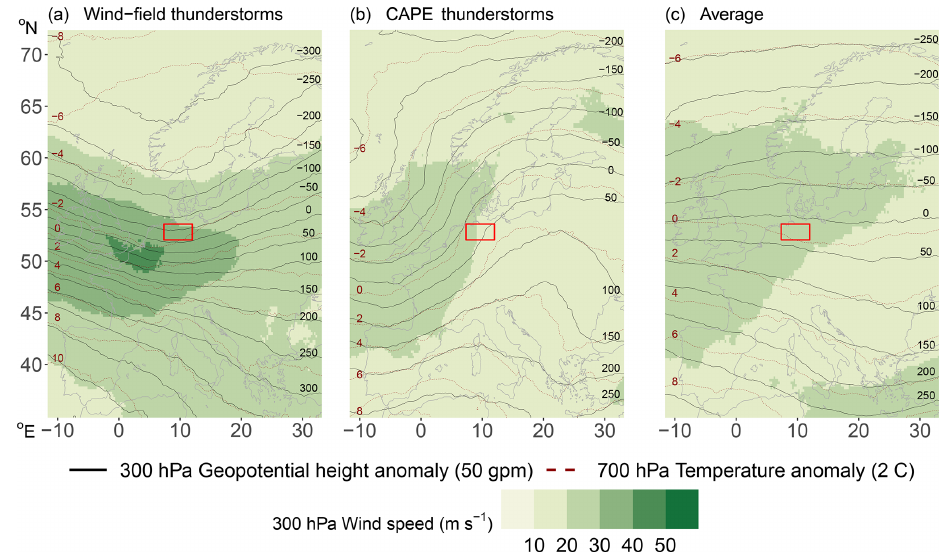
Figure 7. Median weather charts for the clusters in the observational region (red rectangle) showing wind speed (colors) and anomalies of geopotential height relative to the mean (solid black lines) at 300hPa and temperature anomalies at 700hPa (dotted red lines). Number of charts composed for each cluster: 1729 for the wind-field thunderstorms (a) , 1096 for the CAPE thunderstorms (b) , and 2591 for the average cluster (c)